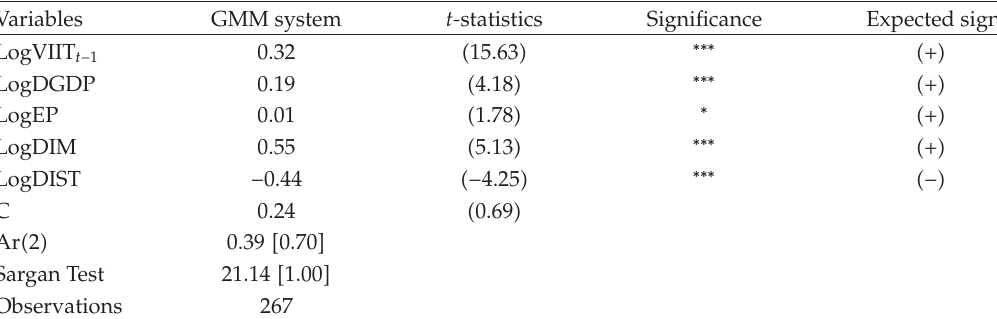
Figure 3: Distribution of horizontal intraindustry trade (cid:2) HIIT (cid:3) . Table 5: Determinants of vertical intraindustry trade.